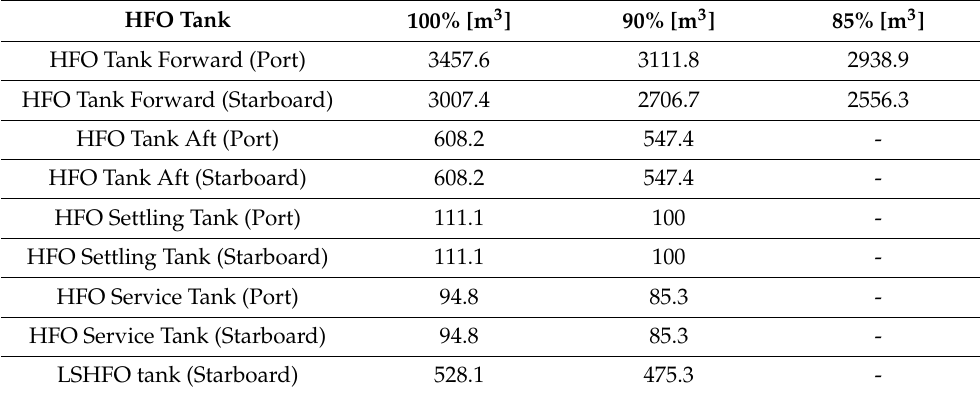
Table 1. Total HFO bunker capacity in cubic